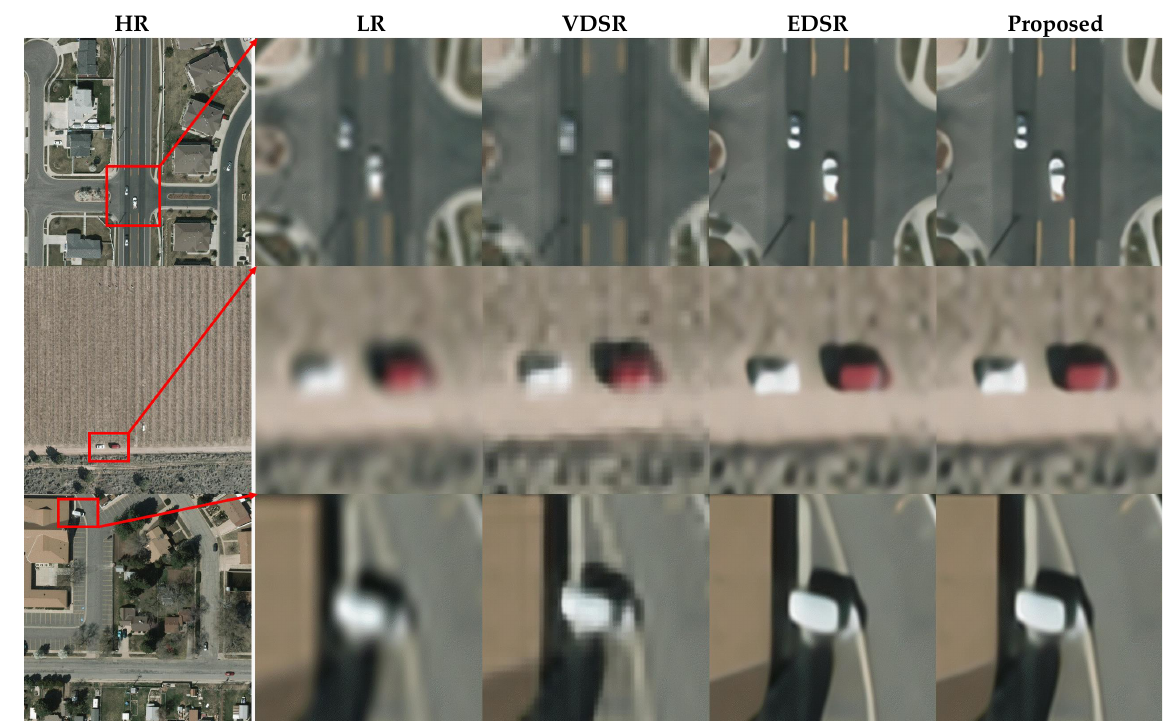
Figure 3. Visual comparisons: VISIBLE images from VEDAI-VISIBLE dataset.